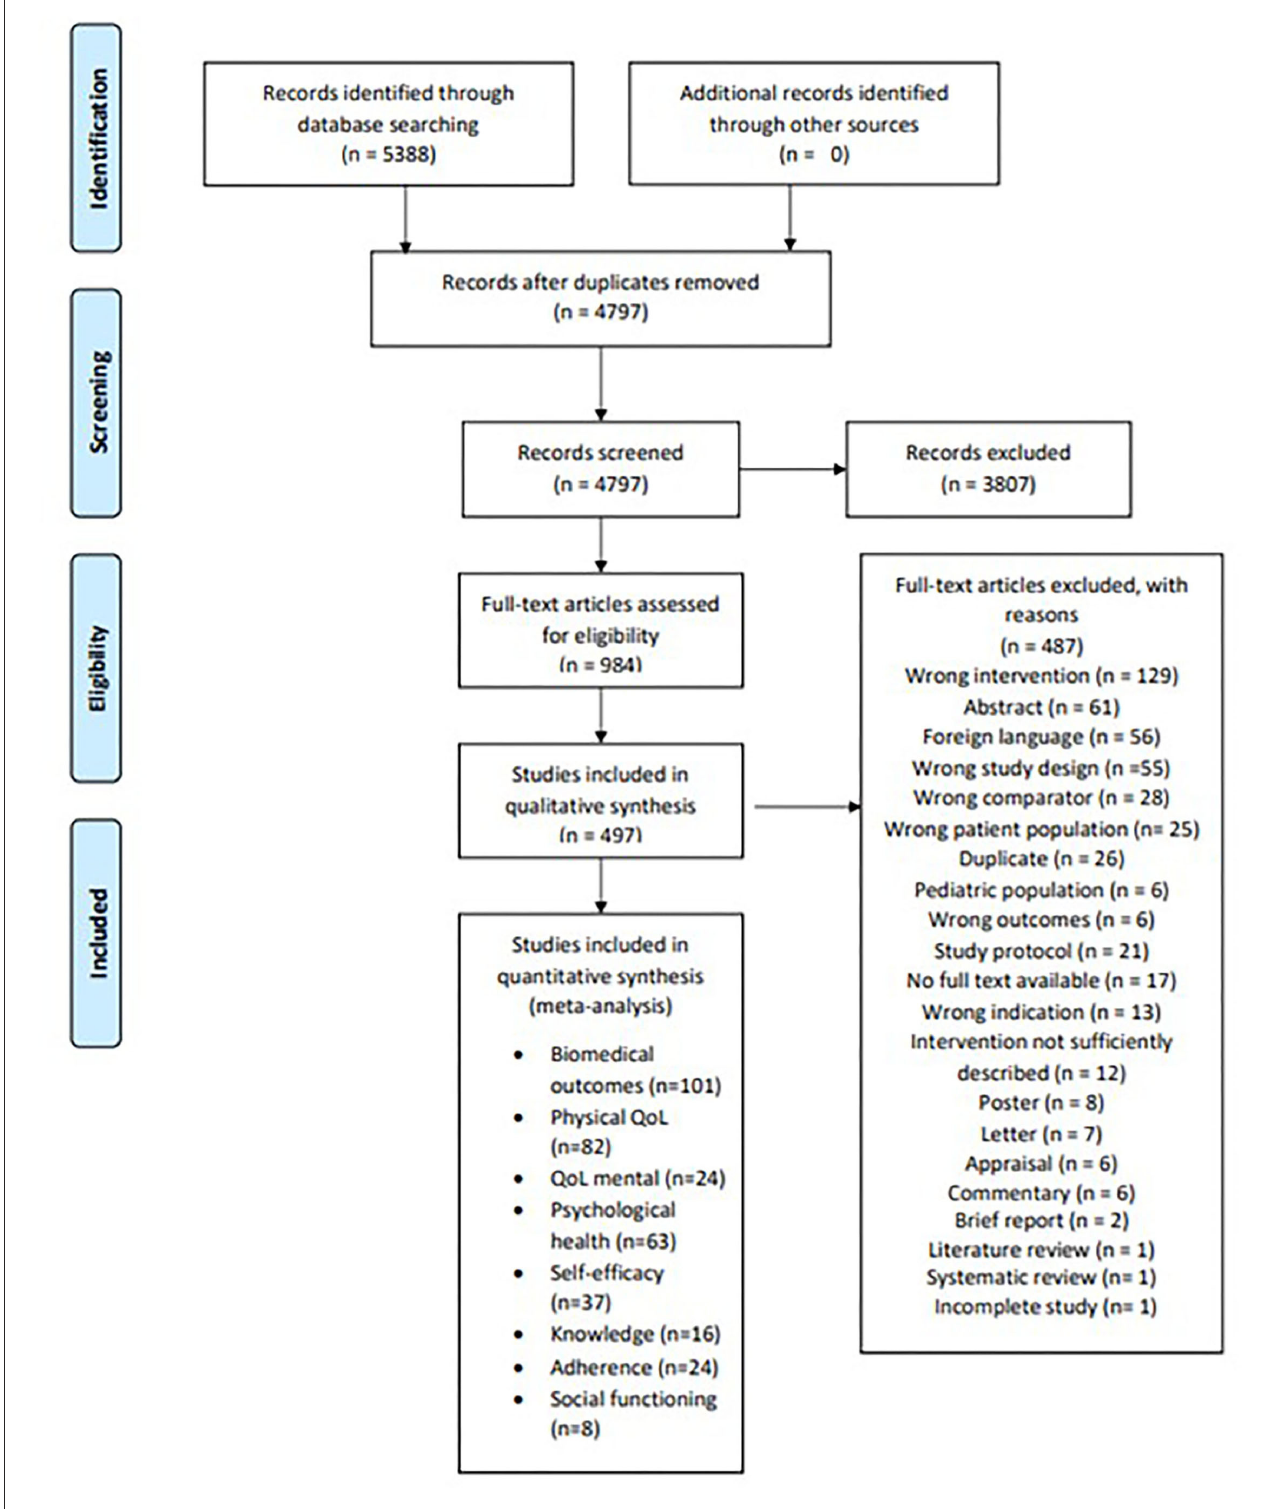
FIGURE1 PRISMA flowchart demonstrating the process of the screening process of studies.